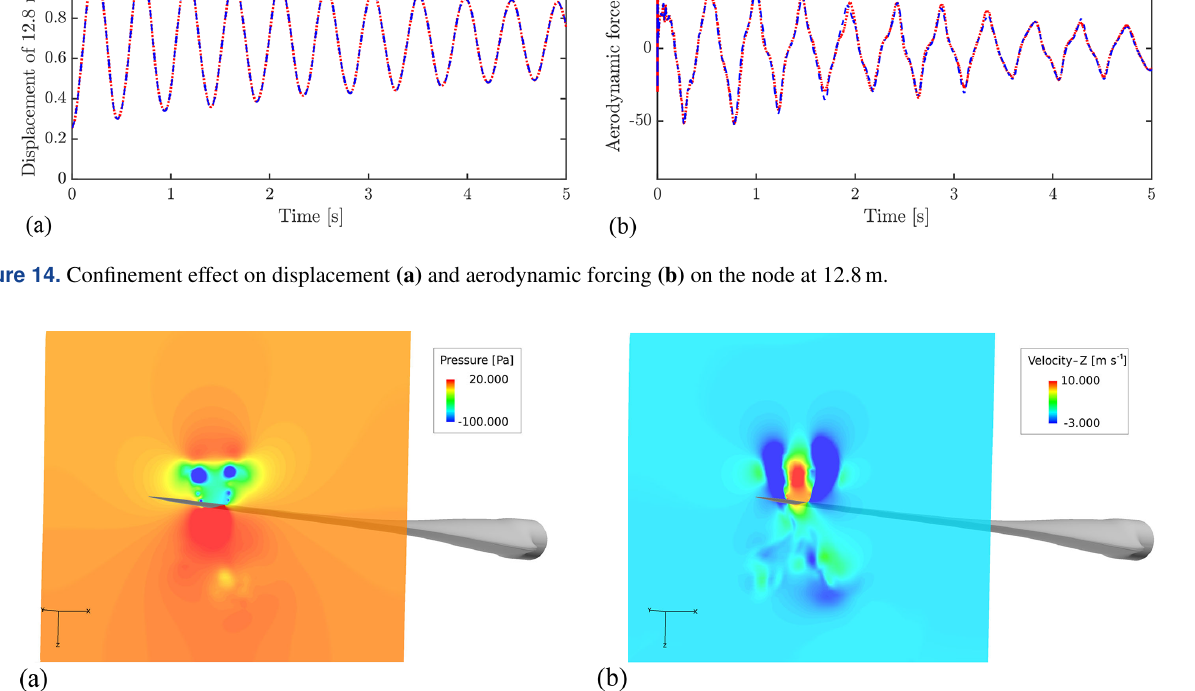
Figure 15. Confined configuration: (a) pressure field and (b) vertical ( z ) velocity